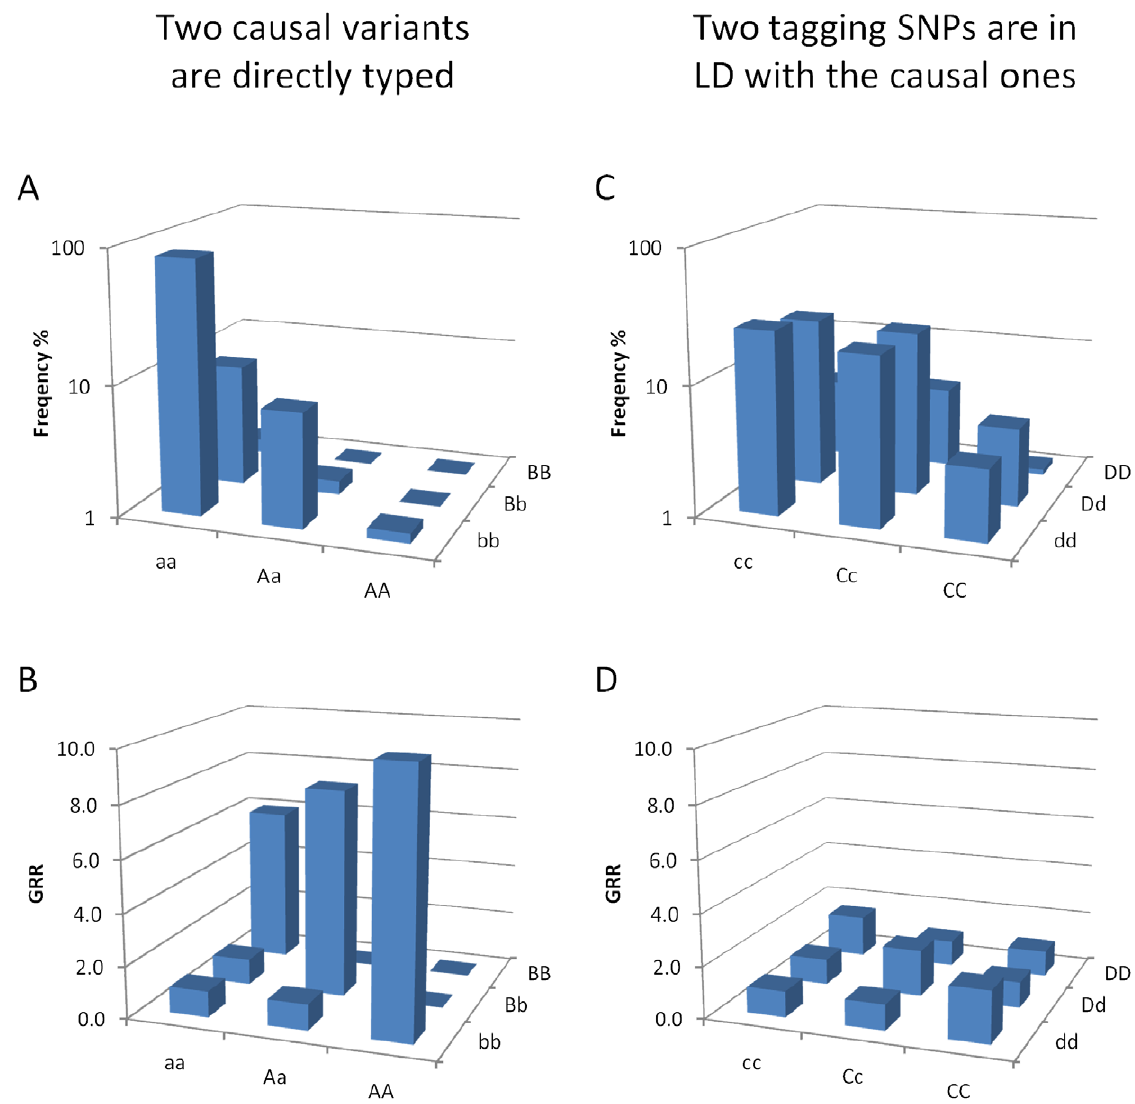
Figure 1. A recessive and compound heterozygote model of the phenotype. At left part of the figure (A and B) two rare recessive variants at the same gene locus are assumed to be directly genotyped. At the right part of the figure (C and D) two non-causal SNPs with higher minor allele frequencies and in LD with the causal SNPs are genotyped. The upper part of the figure depicts the logarithm scaled frequency of the cross genotypes of two variants (A and C). The lower part of the figure is an example of the genetic model under illustrative parameters. GRR AA =8, GRR AaBb =7, GRR BB =6, r ac2 = r bd2 =0.1 (B and D).